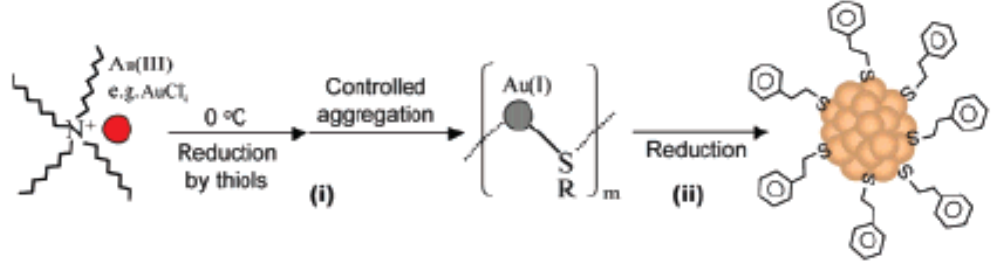
nanoclusters 25